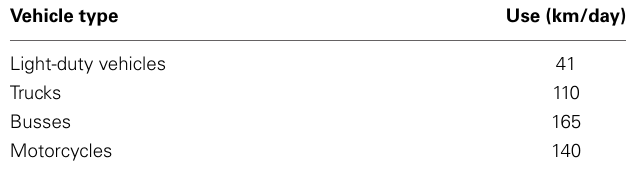
Table 6 | Intensity of use, by vehicle type.